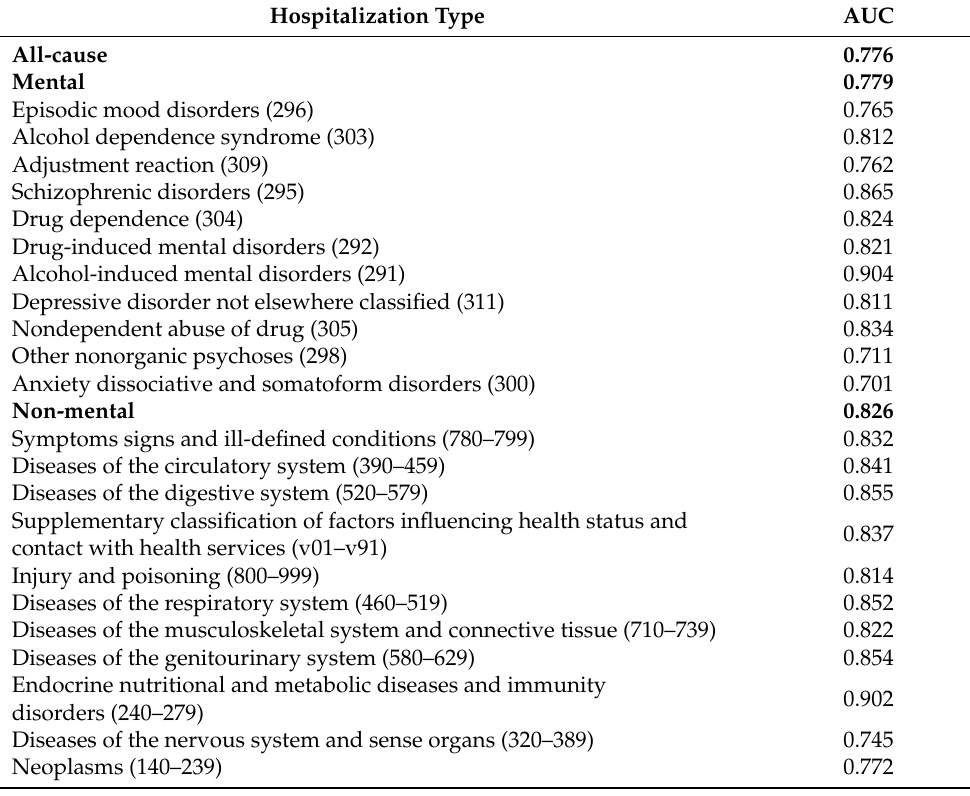
Table 5. Performance comparison across different hospitalization